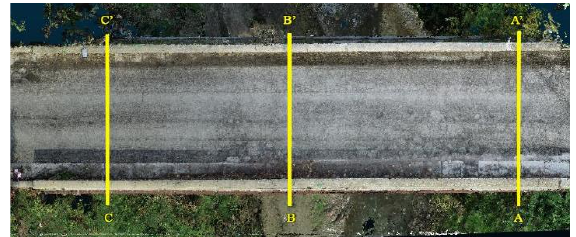
Figure 8. Location of the cross-sections